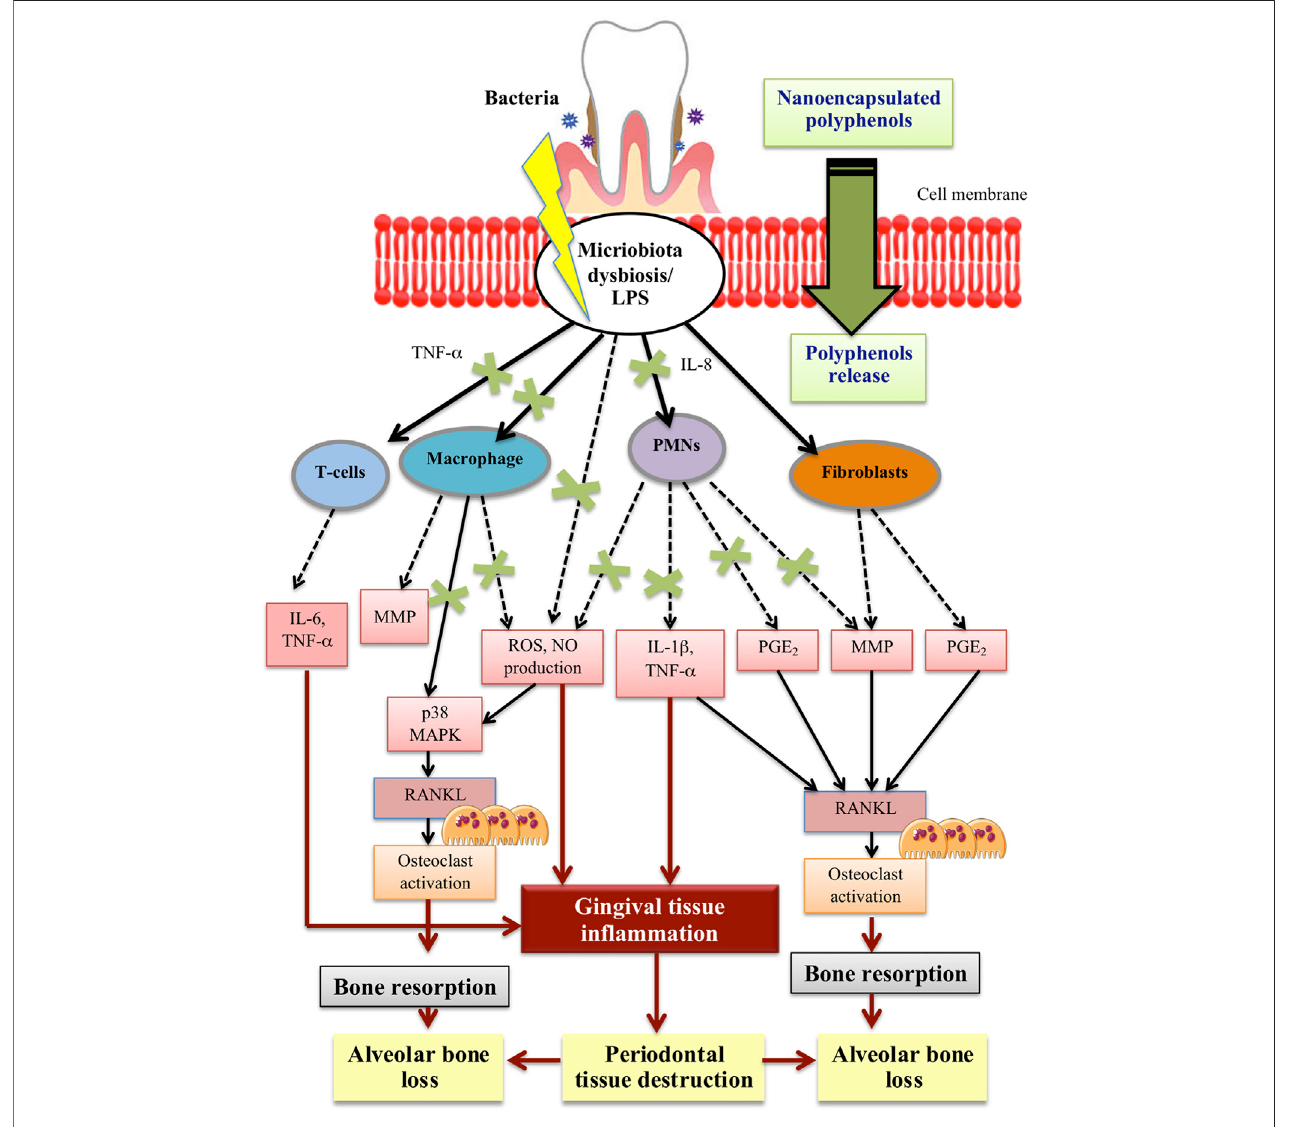
FIGURE 1 | Diagrammatic representation of the nanoencapsulated polyphenols effect on the main cellular pathways involve in periodontal in fl ammation.